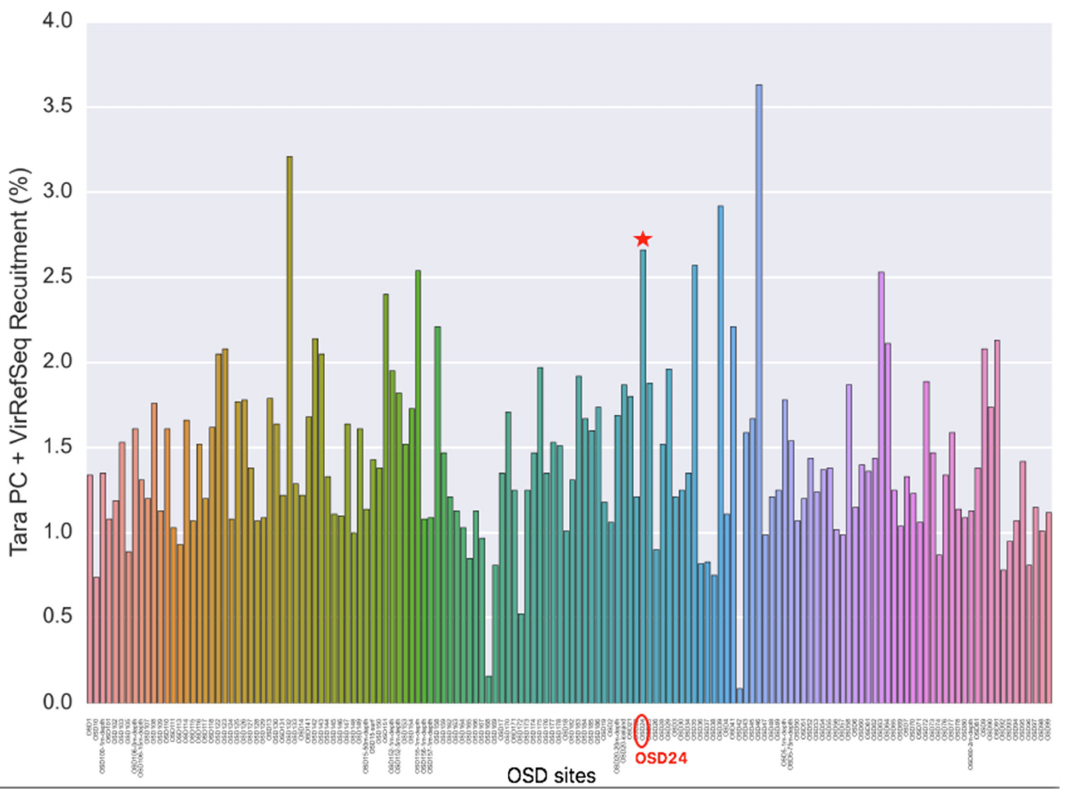
Figure 6. Proportion of reads mapping to viral contigs in OSD metagenomes. Legend: OSD24: Marchica lagoon.